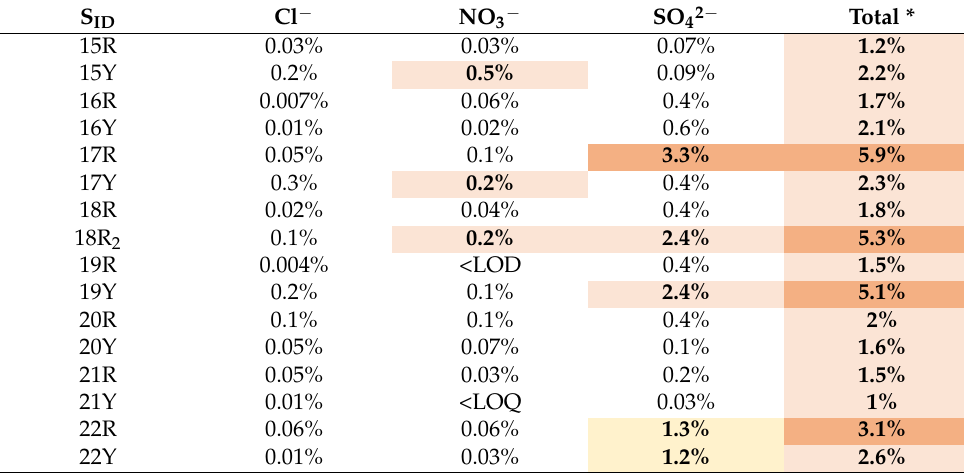
Table 4. Summary of the soluble salt results on bricks expressed in weight percentage ( w/w %). The ionic concentrations considered dangerous by European standards are highlighted, despite other salts being present. The samples that exceed the risk levels are colored in light orange box (low risk), medium orange box (middle risk) and dark orange box (high risk).